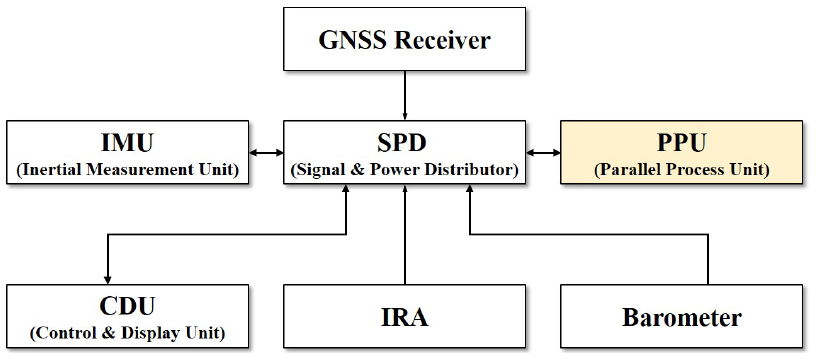
Figure 1. Overview of an advanced precision terrain aided navigation system